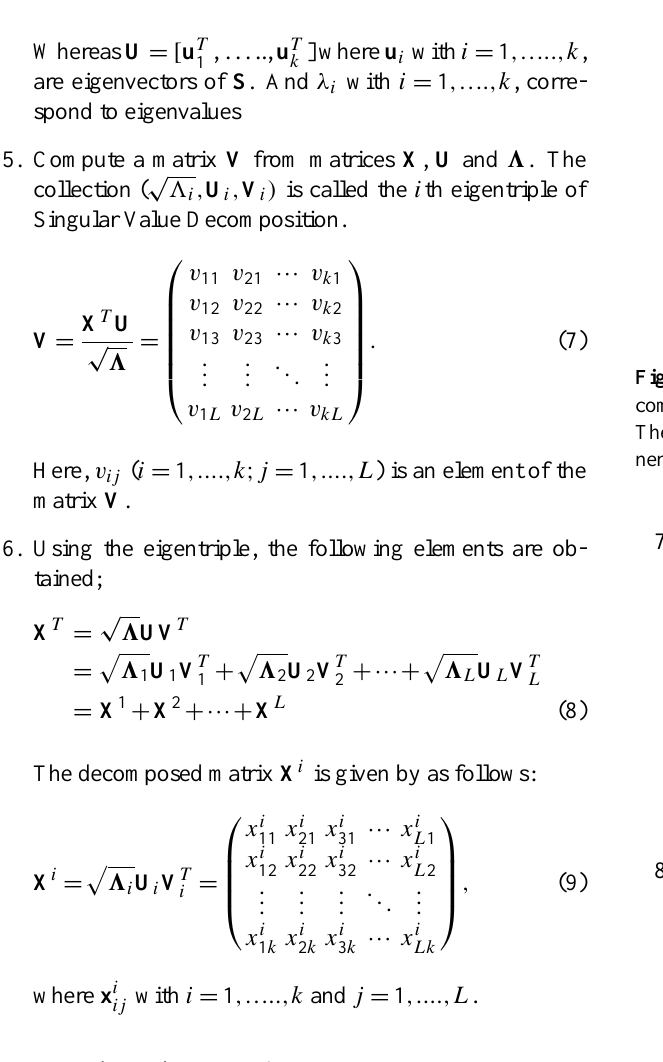
Fig. 6. The DC-driven train noise model for the simulation. (a) an example of the DC-driven train noise model, (b) white noise to be added to the simulated data, and (c) an example of simulated data (a+b) .